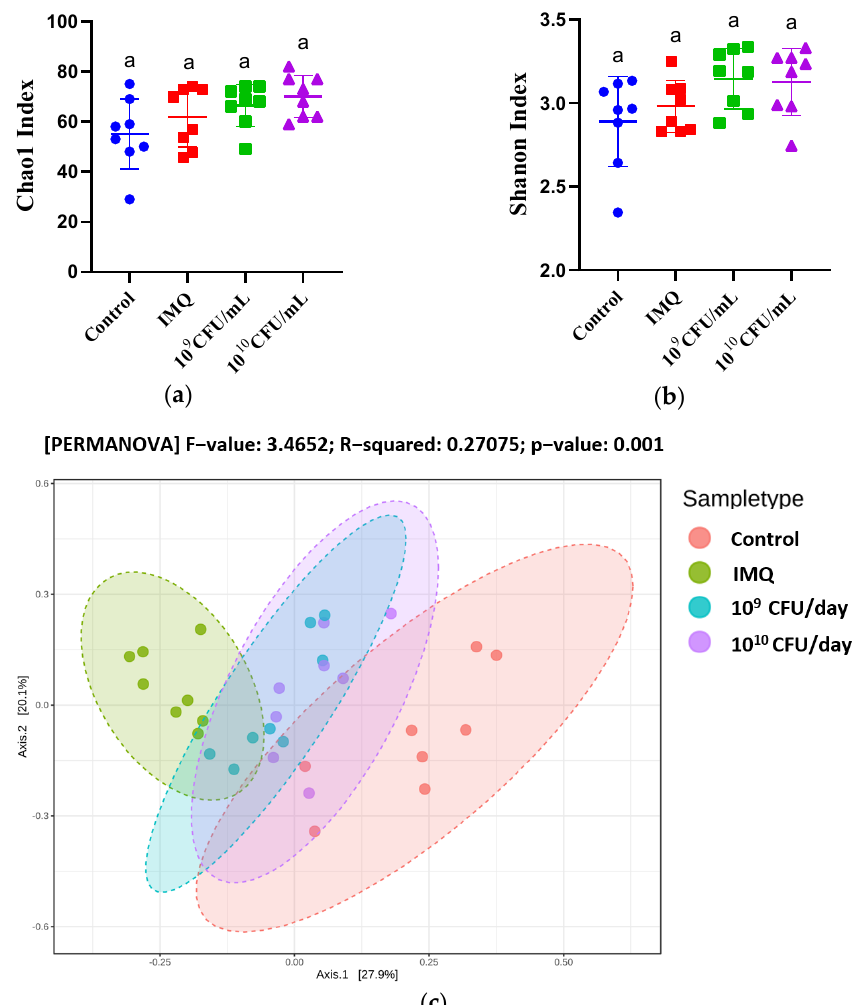
Figure 9. Effect of CCFM683 treatment on the gut microbial diversity in psoriasis mice. The α -diversity includes ( a ) Chao1 and ( b ) Shannon indices. ( c ) PCoA comparing the microbiota structure of CCFM683-treated mice. Groups with different letters are significantly ( p < 0.05) different from each other.